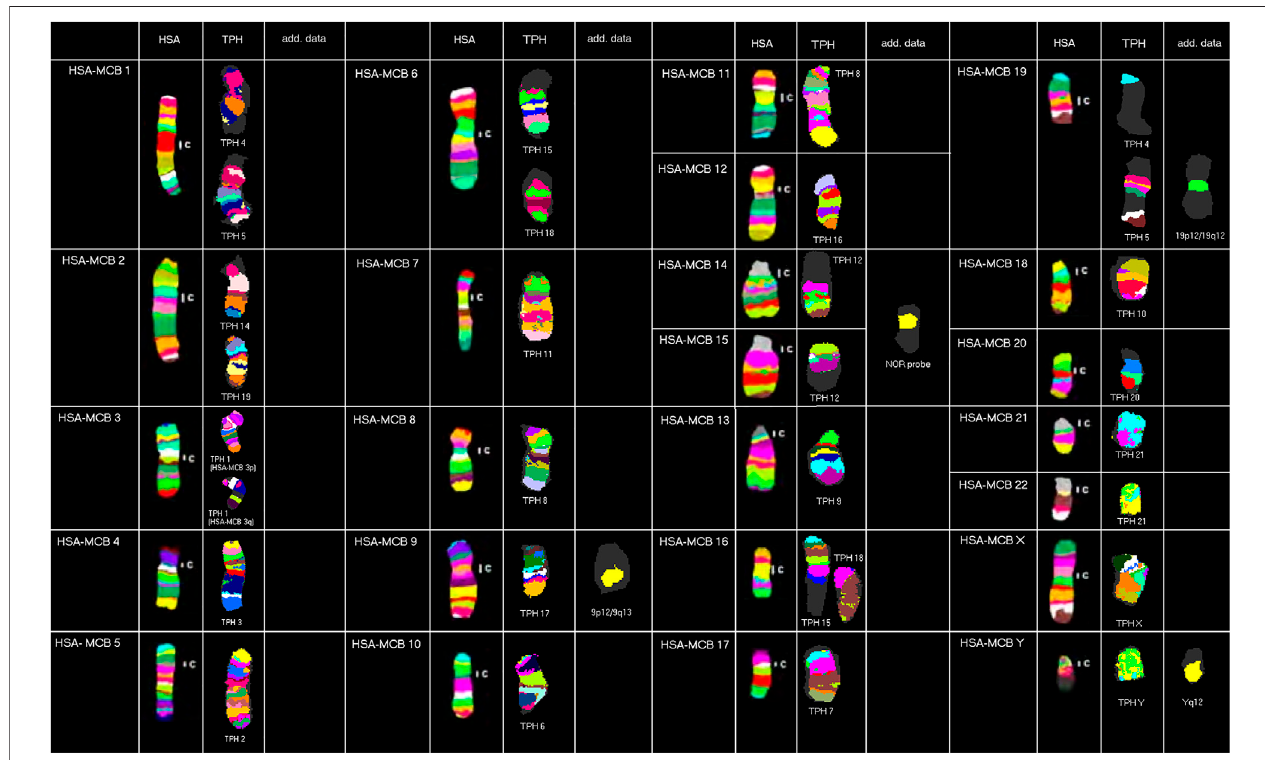
FIGURE1| RepresentativeresultsfromthisstudyusinghumanMCB,NOR,andhumanheterochromatin-speci fi cprobesonTPHaredepictedaspseudo-colored results for HSA and TPH (only valid for MCB results). The chromosomes are sorted here according to the HSA-chromosomes by using MCB. TPH chromosomes are numbered according to Nie et al. (1998).